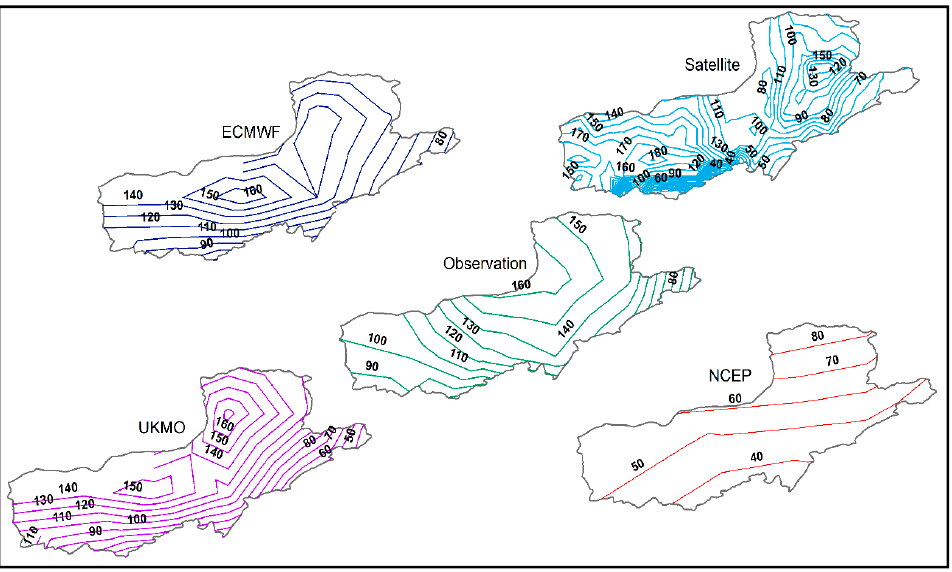
Figure 4. Isohyet contours in the Gorganrud Basin during the first flood event.